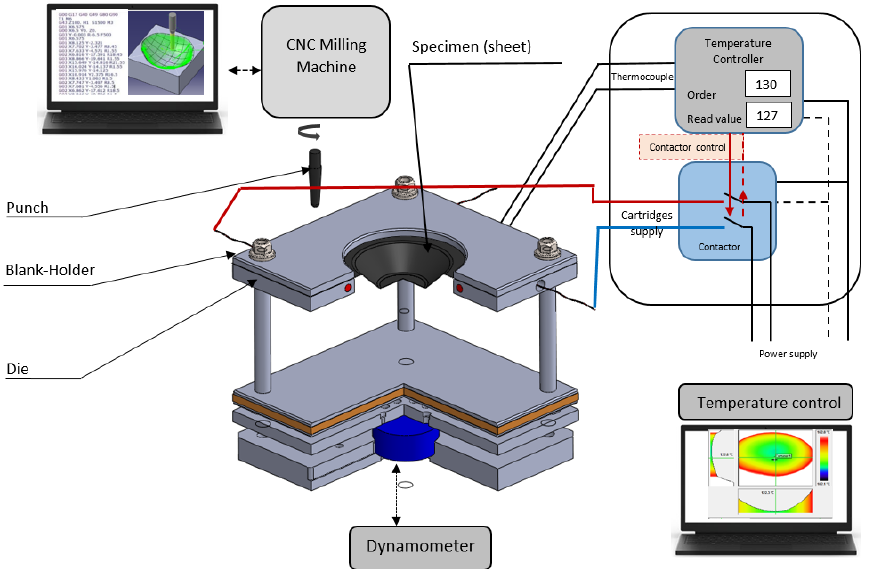
J. Manuf. Mater. Process. 2021 , 5 , x FOR PEER REVIEW Figure 2. Warm incremental sheet-forming setup (WSPIF). Figure 2. Warm incremental sheet-forming setup (WSPIF).